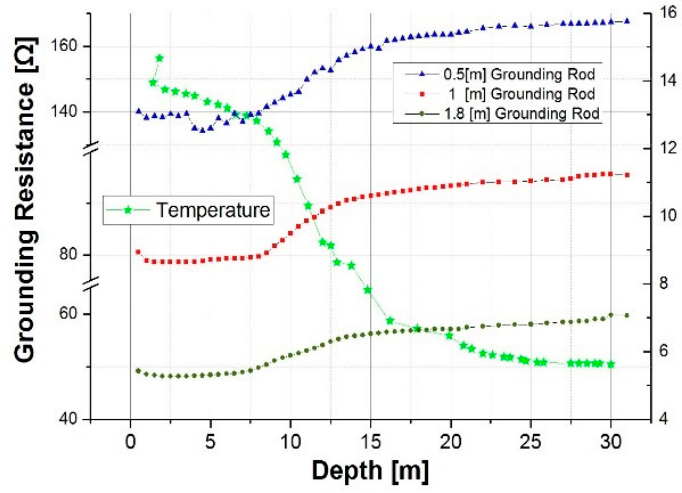
Figure 9. Comparison between grounding resistance and water temperature.